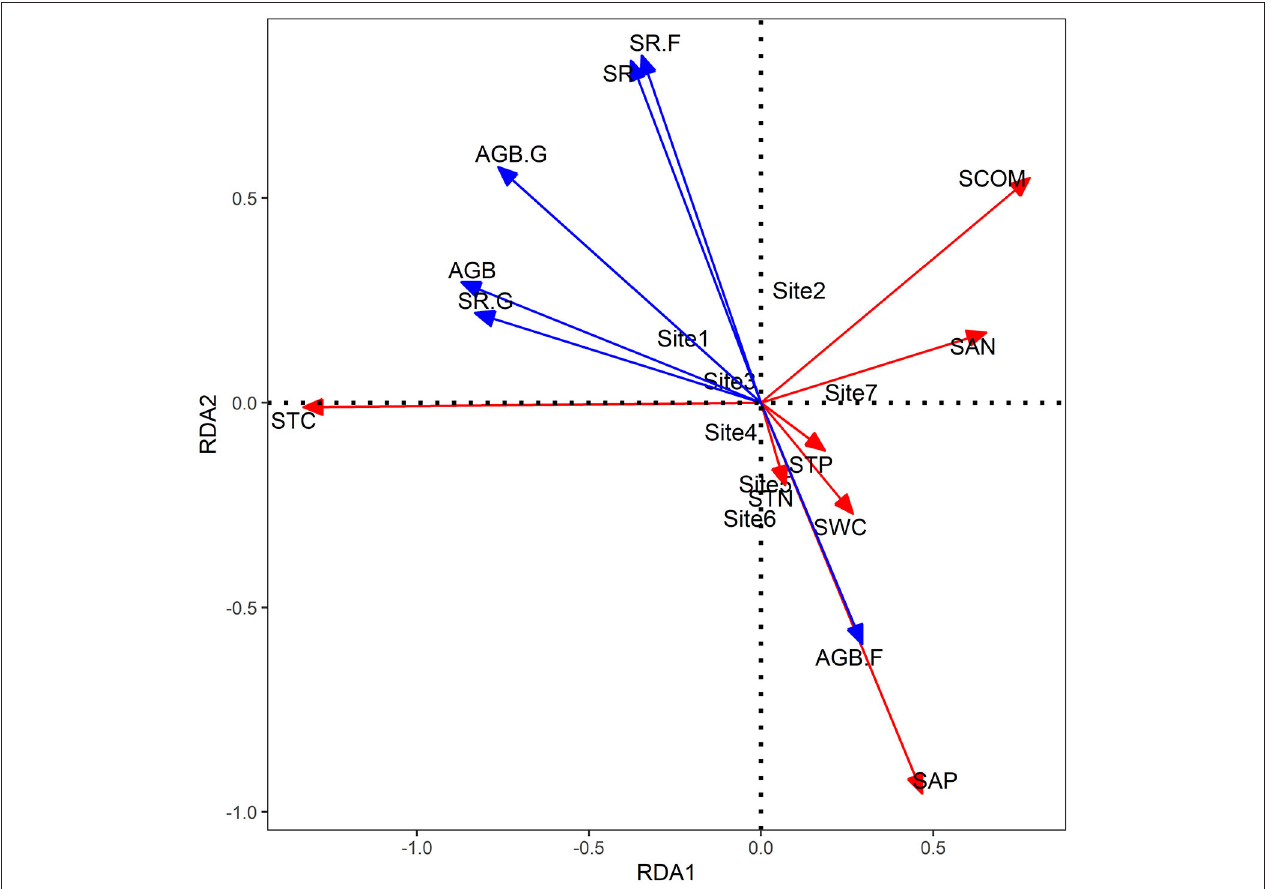
FIGURE 2 | The redundancy analysis of soil variables and vegetation characteristics with different degrees of degradation. The red and blue arrows represent soil variables and vegetation characteristics, respectively. STC, STN, SAN, SAP, STP, SCOM, SWC, AGB, AGB.G, AGB.F, SR, SR.G, SR.F represent soil total carbon, soil total nitrogen, soil available nitrogen, soil available phosphorus, soil total phosphorus, soil compactness, soil water content, overall aboveground biomass, aboveground biomass of graminoids, aboveground biomass of forbs, overall species richness, species richness of graminoids, and species richness of forbs,